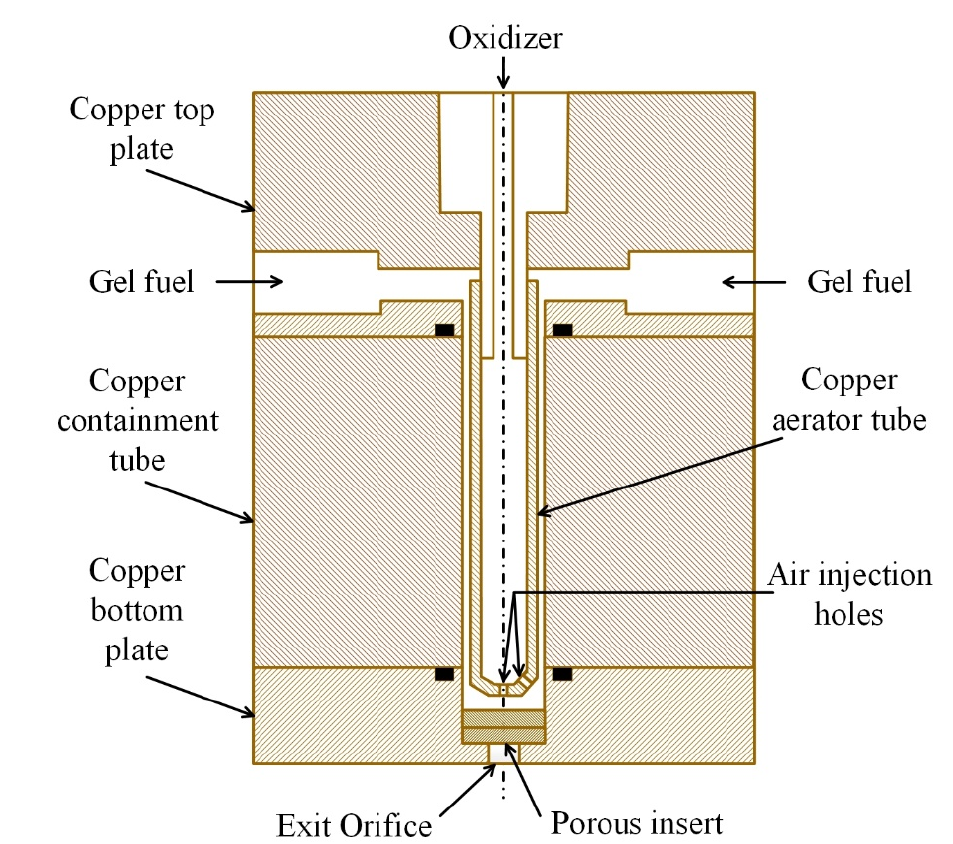
Figure 10. Schematic representation of the flash-boiling atomizer [166].